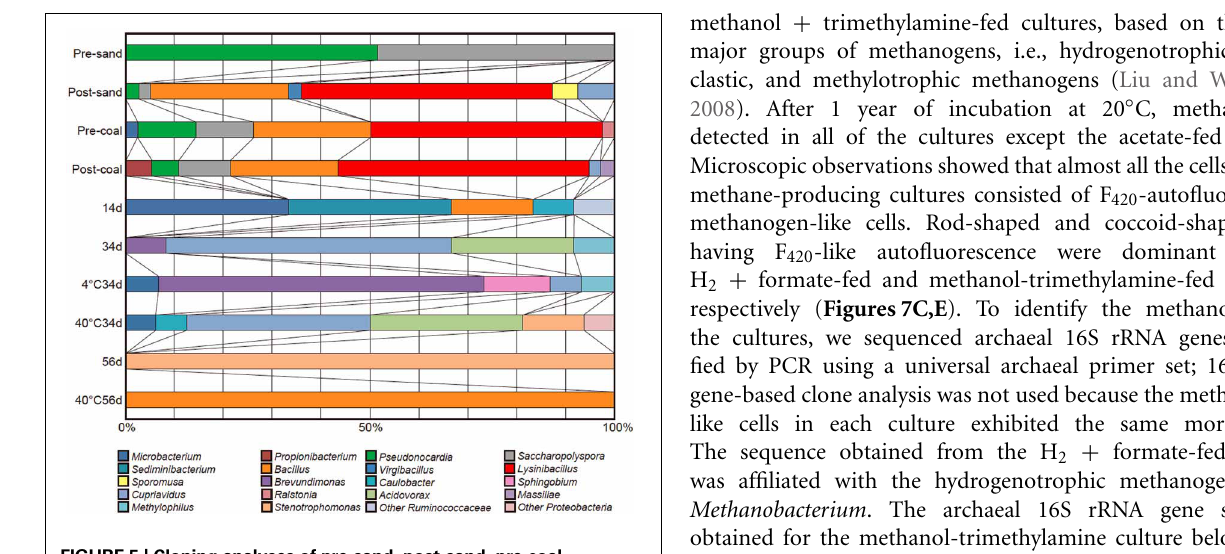
FIGURE 5 | Cloning analyses of pre-sand, post-sand, pre-coal, post-coal, sup-sampled fluids (Samples 14d, 34d, and 56d), and the cultivated samples (Samples 4 ◦ C34d, 40 ◦ C34d and 40 ◦